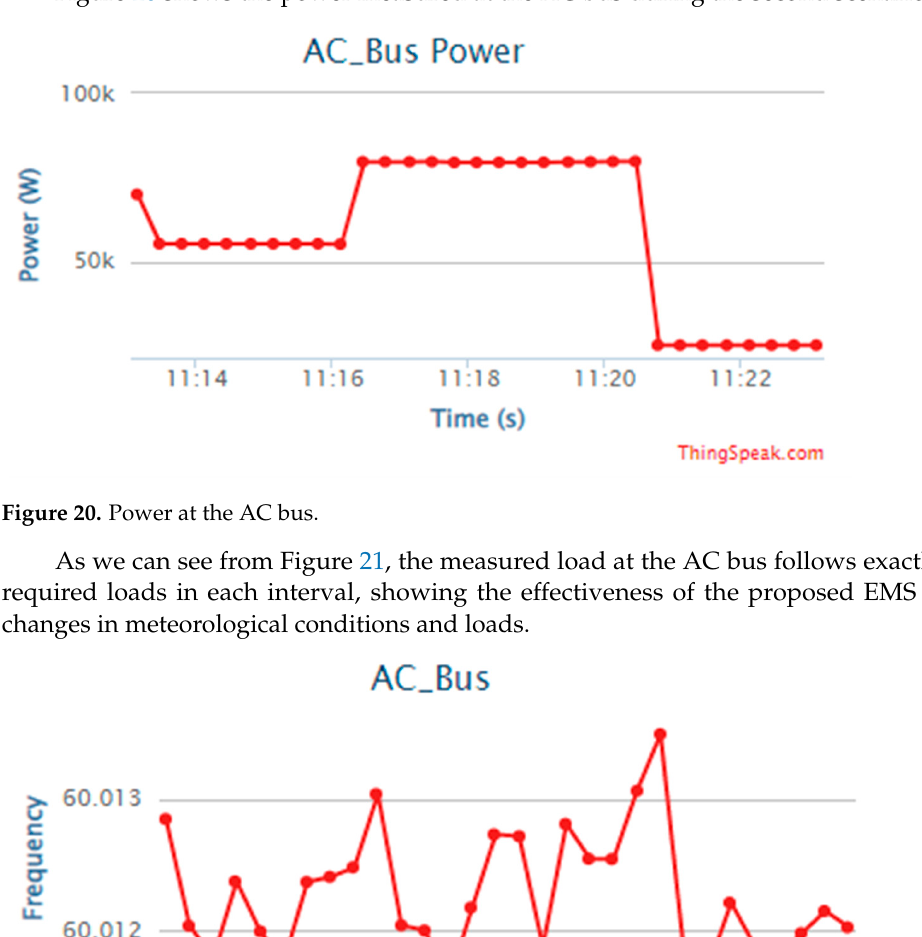
Figure 19. The voltage of DC bus.